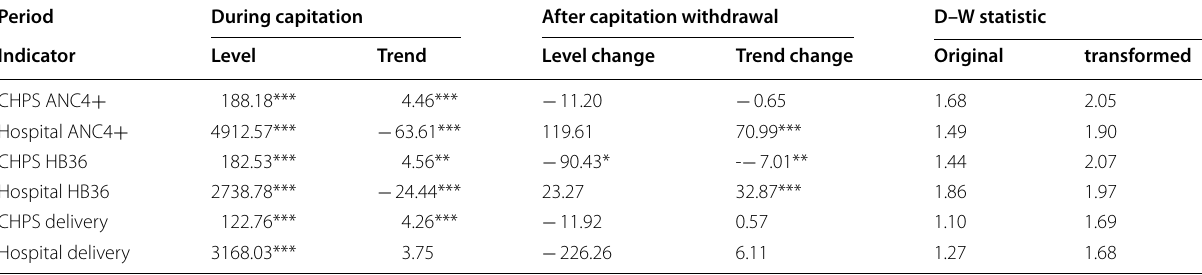
Table 2 Regression results of the effect of the withdrawal of capitation on maternal health care